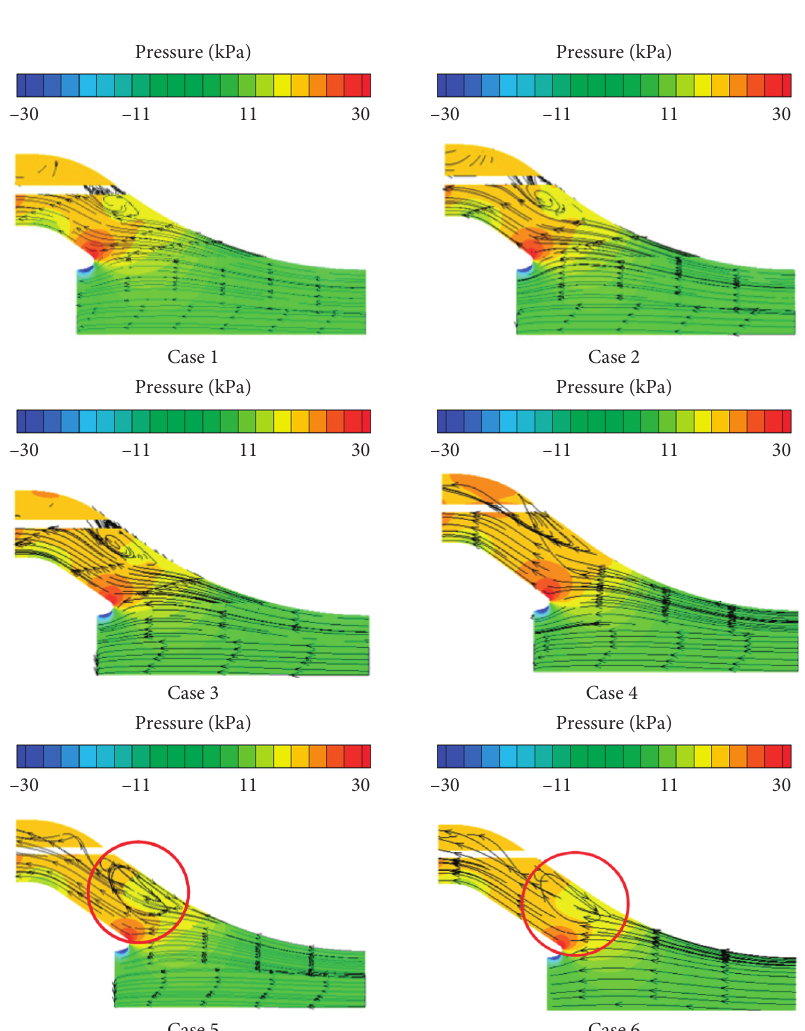
Figure 13: The static pressure streamline diagram of the cross section in different inlet duct